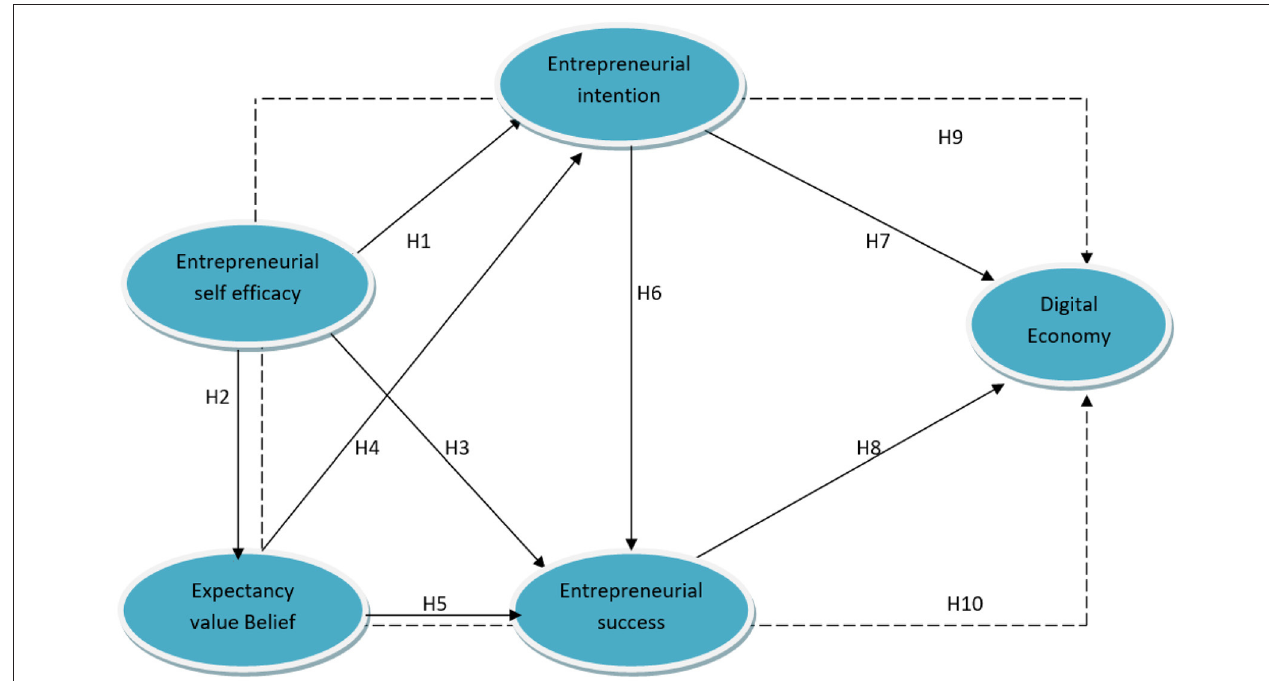
FIGURE 1 | Theorethical